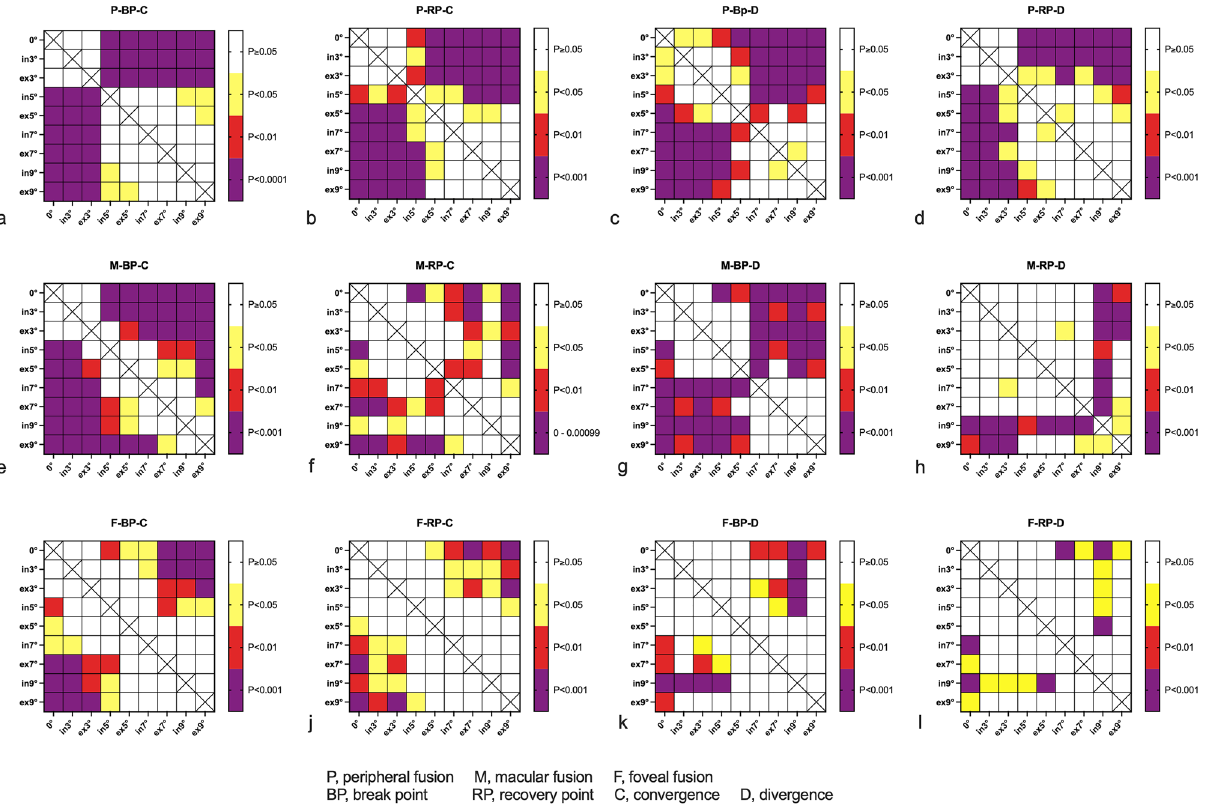
Figure 3. The results of the Tukey multiple comparison tests. ( a ) the results of break points of convergent fusion of peripheral field; ( b ) the results of recovery points of convergent fusion of peripheral field; ( c ) the results of break points of divergent fusion of peripheral field; ( d ) the results of recovery points of divergent fusion of peripheral field; ( e ) the results of break points of convergent fusion of macular field; ( f ) the results of recovery points of convergent fusion of macular field; ( g ) the results of break points of divergent fusion of macular field; ( h ) the results of recovery points of divergent fusion of macular field; ( i ) the results of break points of convergent fusion of foveal field; ( j ) the results of recovery points of convergent fusion of foveal field; ( k ) the results of break points of divergent fusion of foveal field; ( l ) the results of recovery points of divergent fusion of foveal